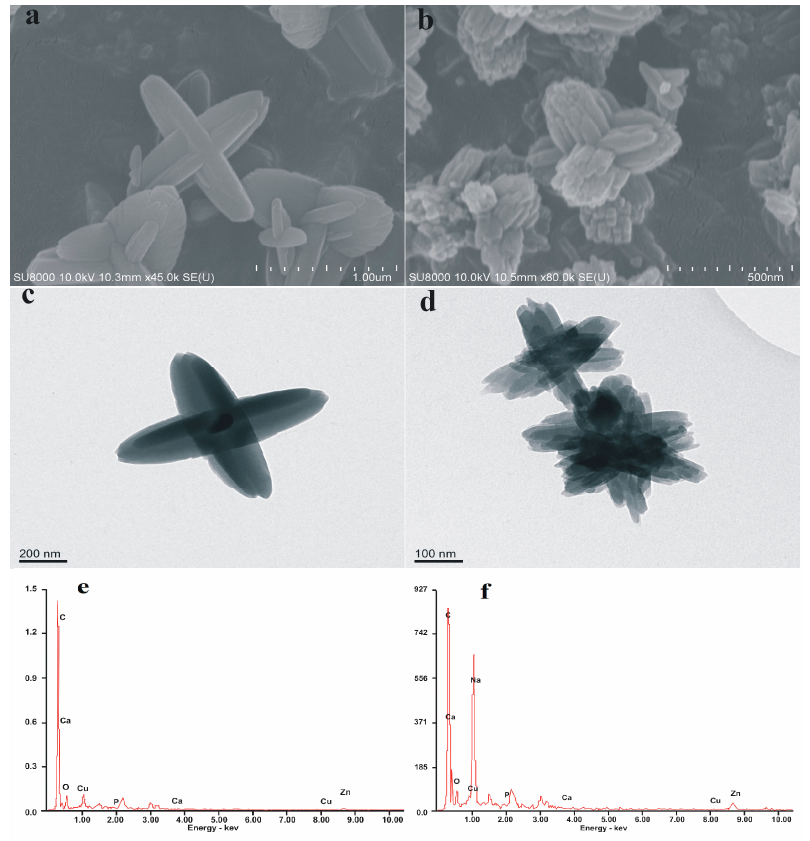
Figure 2. SEM images ( a ) ZIF-8 and ( b ) ZIF-8@RML; TEM images of ( c ) ZIF-8 and ( d ) ZIF-8@RML; EDS patterns of ( e ) ZIF-8 and ( f )